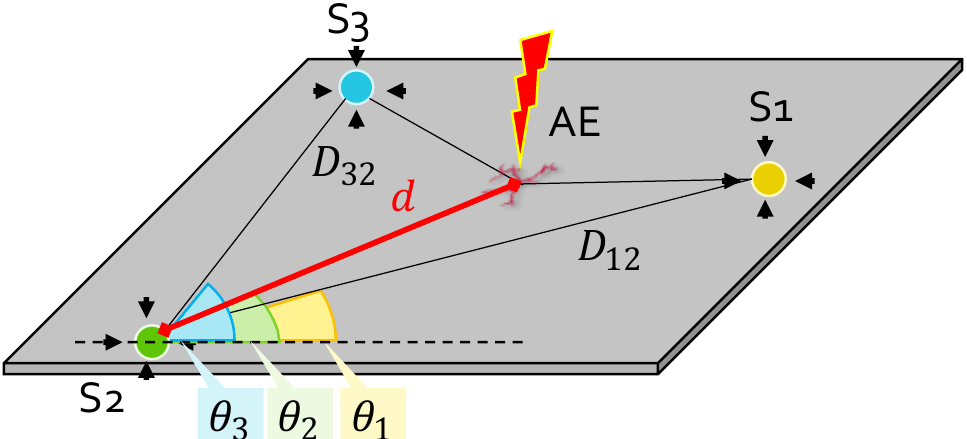
Figure 10. Geometrical representation of the adopted localization model via a three sensor array: the objective is to estimate the AE-to-sensor distance d and its relative direction θ